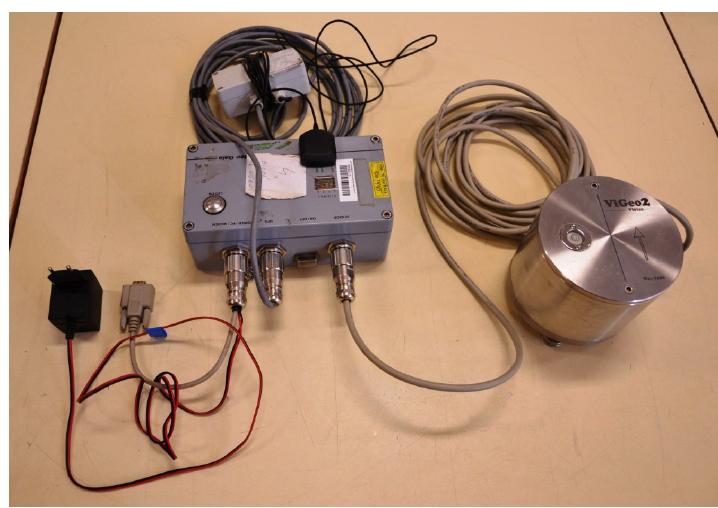
Figure 7. Complete standard seismic equipment: seismic apparatus Gaia2T with the seismometer ViGeo2.